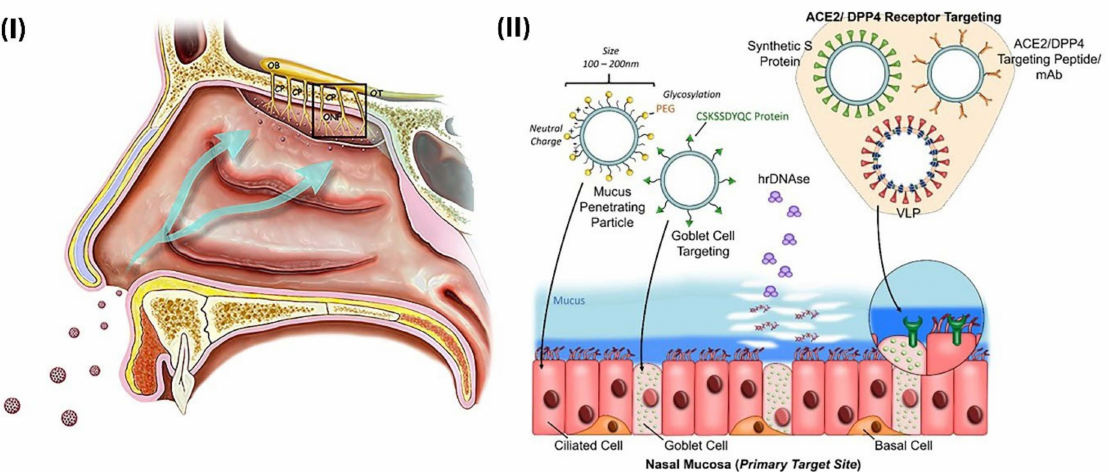
Figure 8. ( I ) Schematic of the route of entry of SARS-CoV-2 and nanoparticles into the nasal cavities and entrapment in the mucosal layer [167] (Reproduced with permission from [167]. Copyright Frontiers, 2020), and ( II ) Including mucosal penetrating nanoparticles for direct targeting of ACE2/DPP4 receptors are nanocarriers based on targeting peptides, targeting ligands (synthetic S proteins) and targeting antibodies. Reproduced with permission from [26]. Copyright Elsevier,